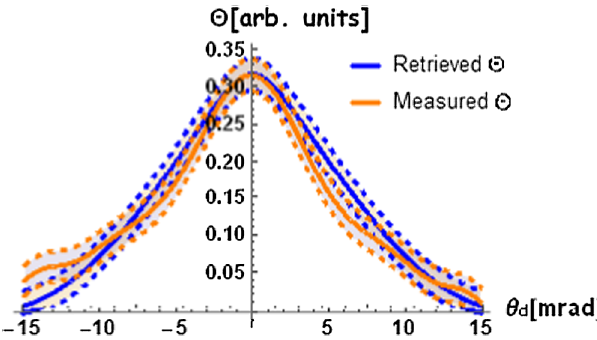
FIG. 6. Comparison between the measured (outside the bubble) and the retrieved (inside the bubble) Θ ð θ d Þ function. Correspond- ing values of beam divergence σ meas θ ¼ 5 . 9 (cid:4) 0 . 6 mrad and 5 . 2 (cid:4) 0 . 6 σ retr θ ¼